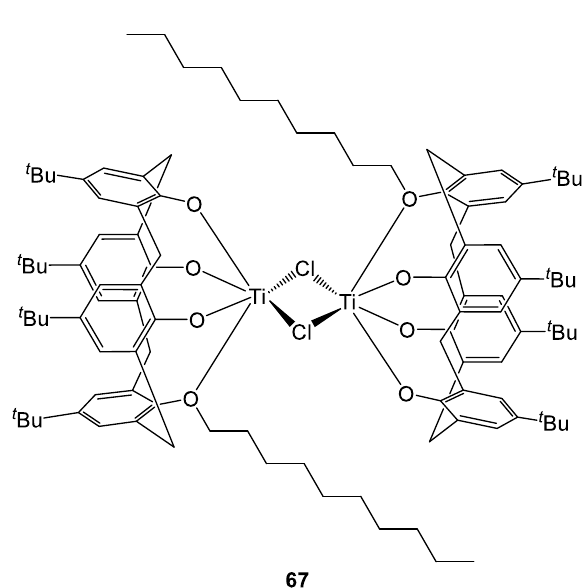
Figure 18. Structure of {[TiL(O) 3 (OR)] 2 ( µ -Cl) 2 } . (R = n -decyl) 67 [29].